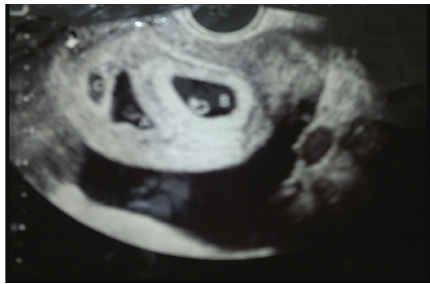
Figure 1: Ultra Sonography showing three gestational sacs with gross